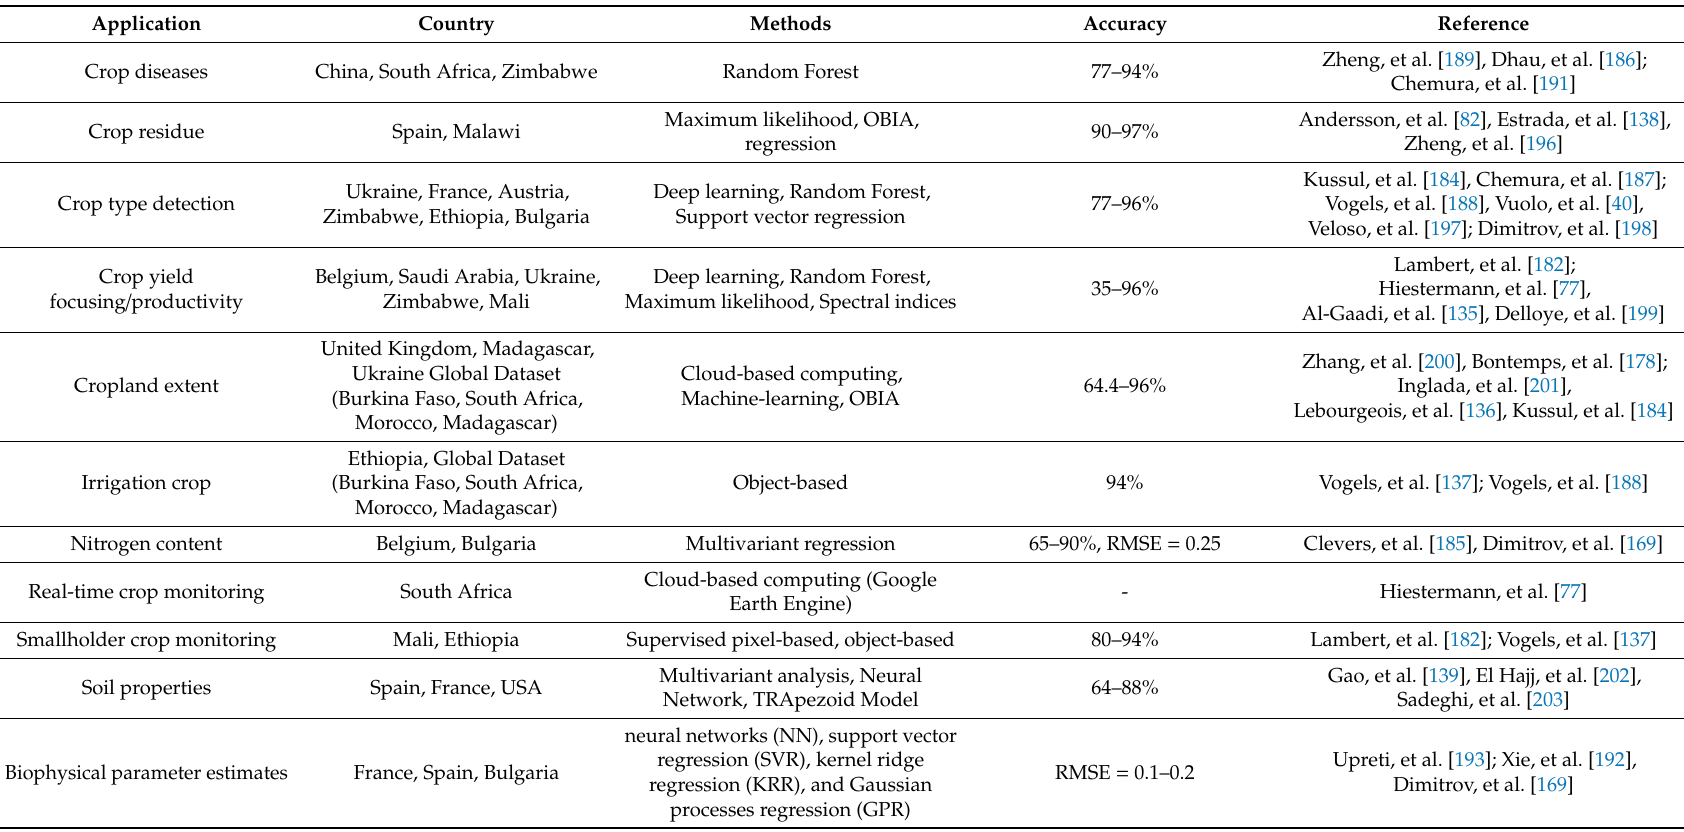
Table 6. Summary of agricultural application of Sentinel-2 imagery